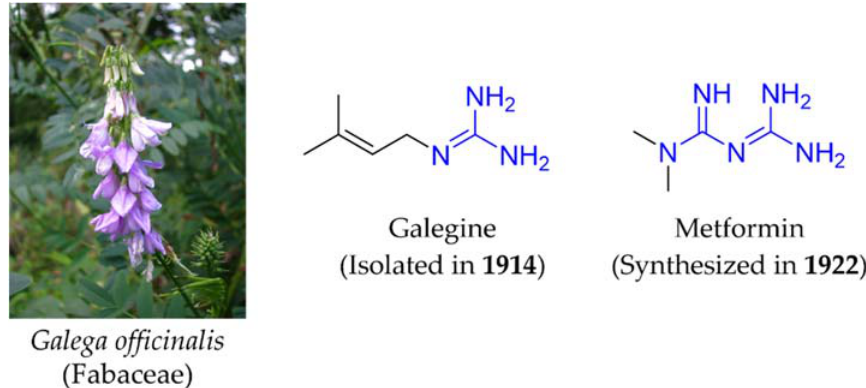
Figure 1. Galega officinalis (Goat’s rue), galegine, and metformin. Chemically, metformin is a hydrophilic base, which exists as a cationic species at a physiological pH. Regarding this poor lipophilicity, passive diffusion of metformin through cell membranes is limited; thus, its uptake and distribution crucially rely on the organic cation transporters (OCTs) which are expressed at significant levels in metformin target tissues such as liver, muscle, and adipose tissue. Deficiency or inhibition of the OCTs impairs the uptake of metformin in the small intestine and the hepatic uptake and elimination and attenuated antiglycemic effect by metformin treatment [11–14]. The mechanism of action of metformin is complex and still not fully understood [15].